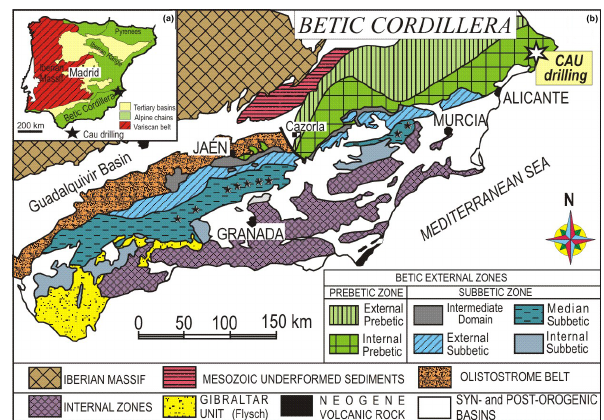
Figure 2. Panoramic view of the Cau section showing the position of the Almadich and Seguilí formations and the three drilling sites, D-1, D-3, and D-4, realized in 2015. Planned drill D-2 (in grey) was considered to be unnecessary and has not been